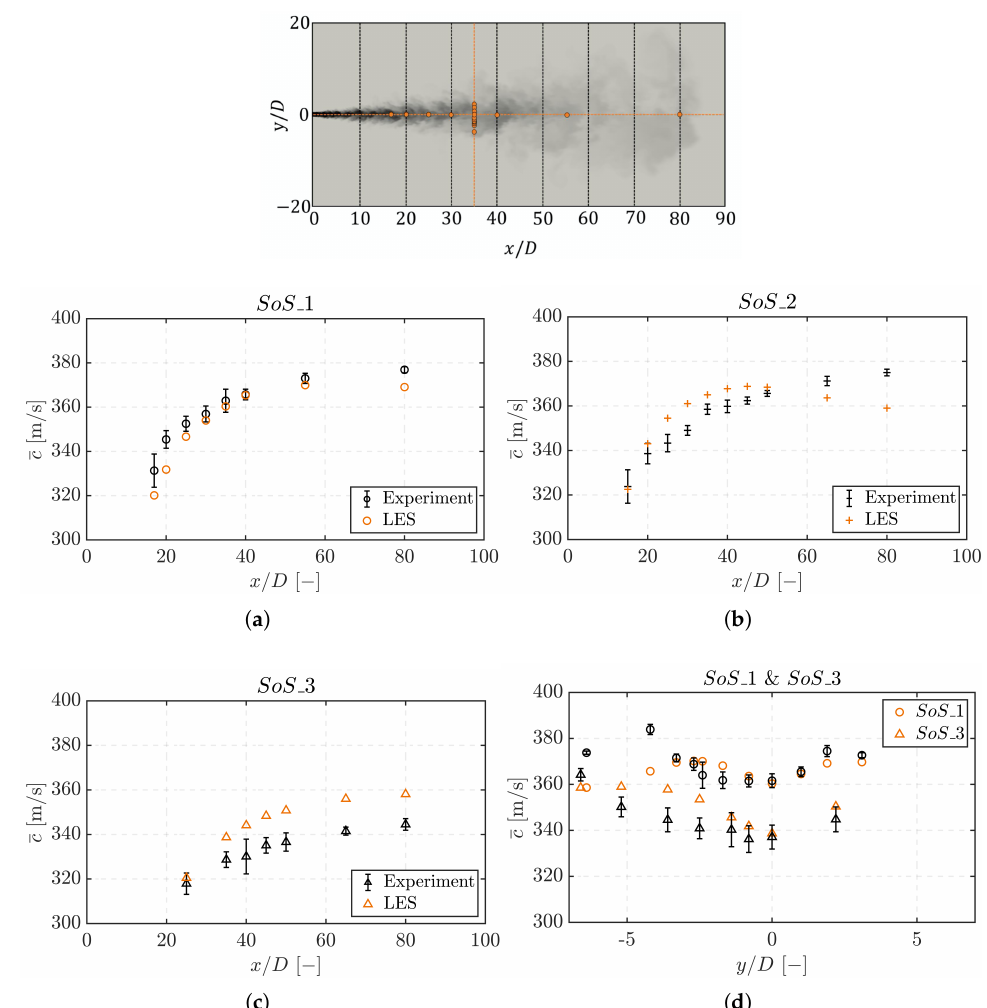
Figure 8. Top panel: Experimental measurement positions of the mixture speed of sound indicated on LES results. Main panel: Comparison of the mixture speed of sound of the LES (orange) and the experiment (black) (error bars represent the double standard error of the sample mean) for the cases SoS _1 ( a ), SoS _2 ( b ), and SoS _3 ( c ) in the axial direction and for the cases SoS _1 and SoS _3 in the radial direction at the position x / D = 35 ( d